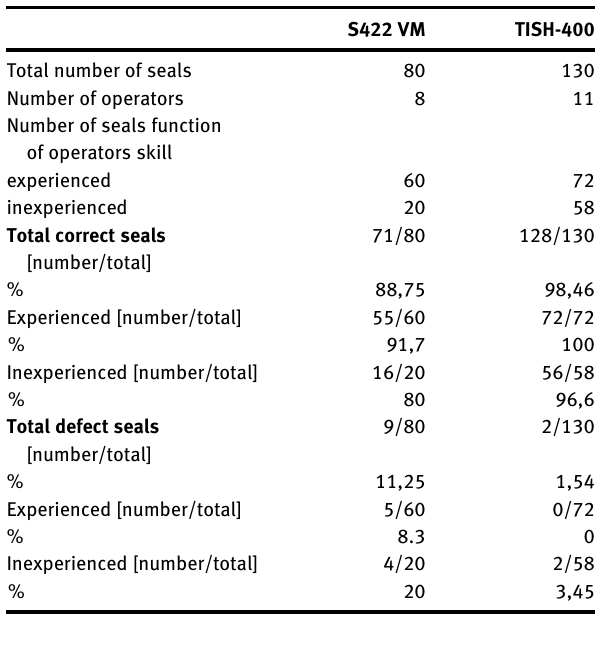
Table  : Resultsoftoluidinebluedyepenetrationtestswithregards to heat sealer (S  VM, TISH-  ) and operators (experienced and inexperienced).